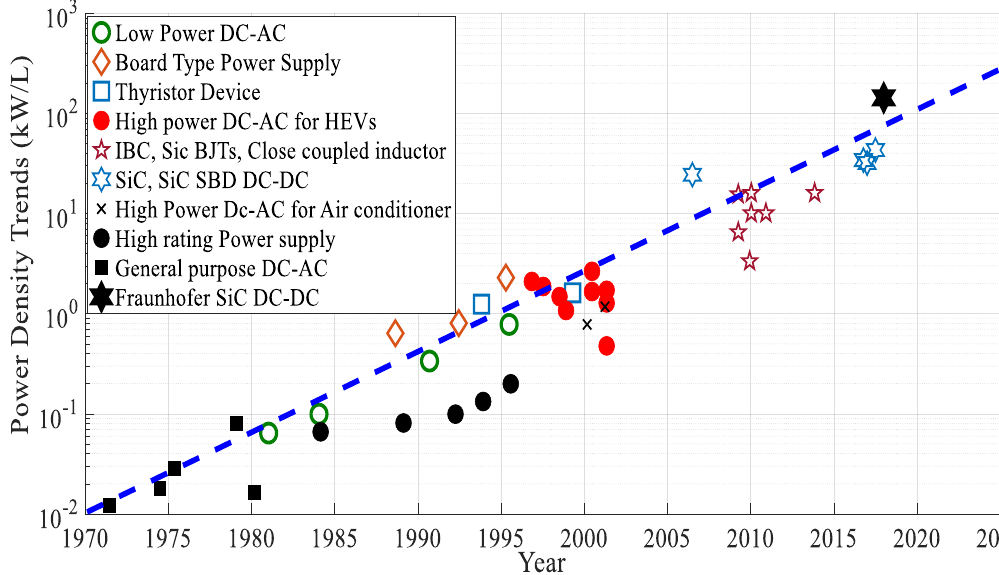
Figure 29. Chart showing the projected growth of power density in power electronics Figure 29 . Chart showing the projected growth of power density in power electronics devices.